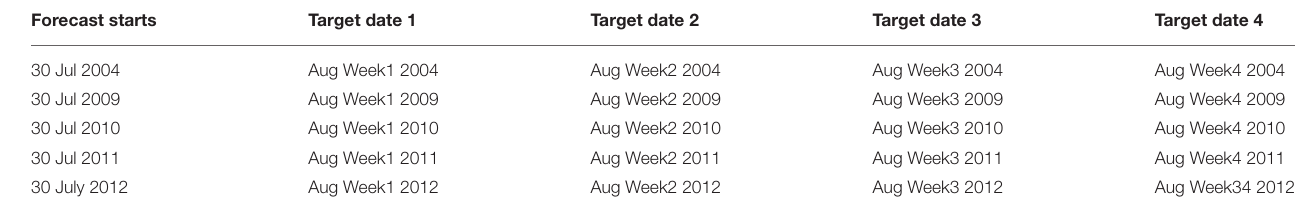
TABLE 1 | Dates of initialization and range of forecasts examined in this study. Forecast